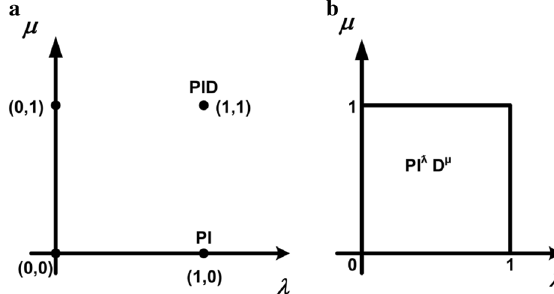
Fig. 5 Representation of controllers in λ - μ plane: a IOPID Controller b FOPID